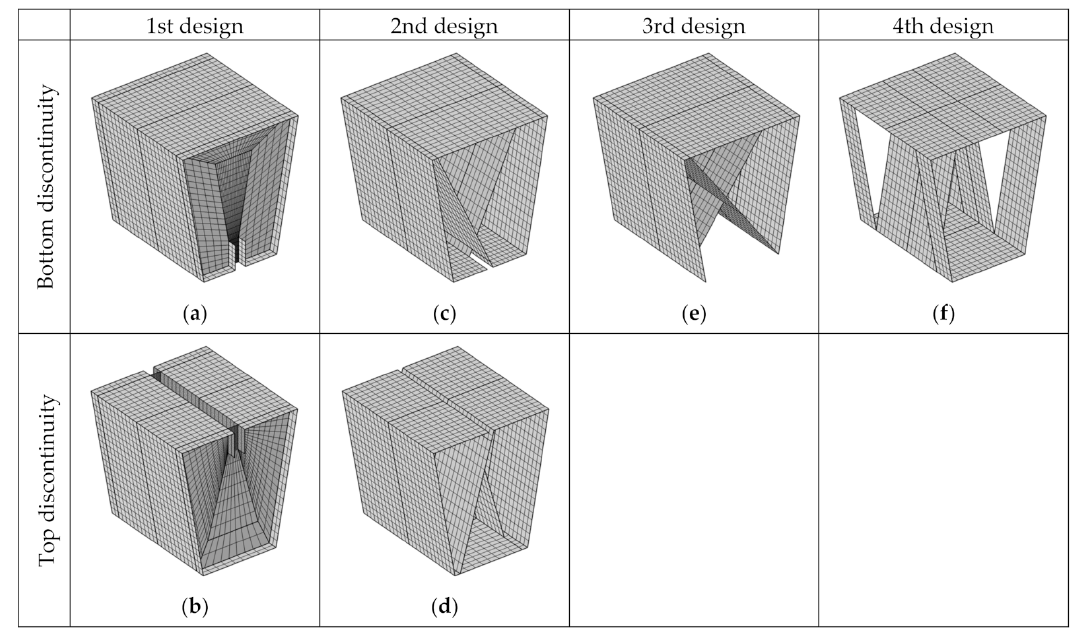
Figure 8. Mapped meshes: ( a , b ) 1st design with bottom/top discontinuity; ( c , d ) 2nd design with bottom/top discontinuity; ( e ) 3rd design; ( f ) 4th